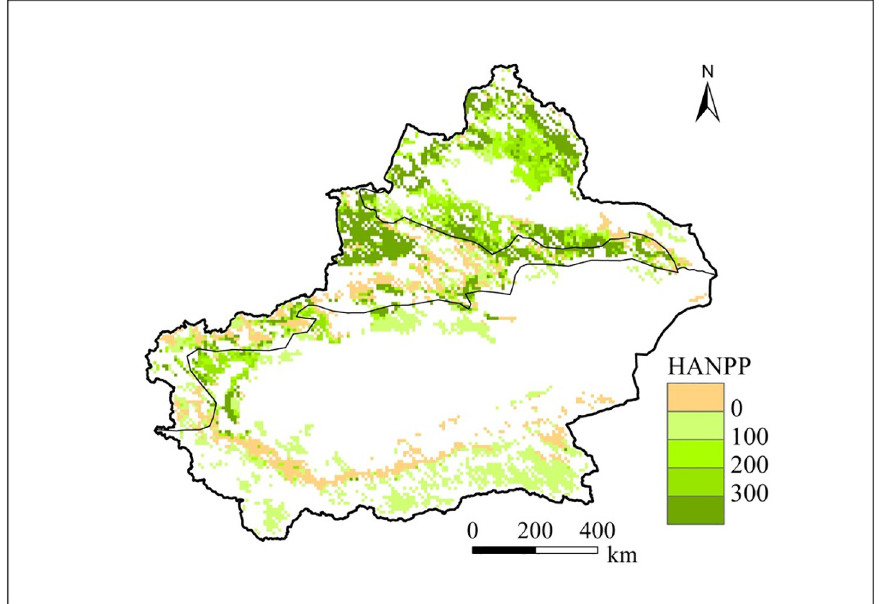
Fig 4. Maps of the average annual HANPP in the Xinjiang grasslands from 1979 to